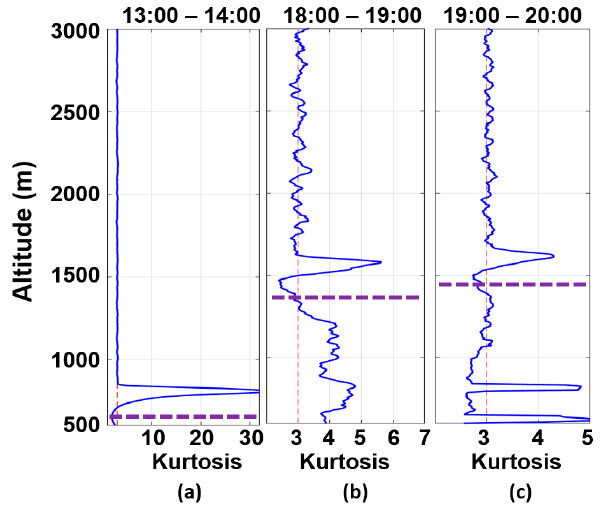
Figure 12. RCS (cid:2873)(cid:2871)(cid:2870) kurtosis profiles obtained on 23 July 2019, between ( a ) 13:00–14:00 UTC, ( b ) Figure 12. RCS 532 kurtosis profiles obtained on 23 July 2019, between ( a ) 13:00–14:00 UTC, 18:00–19:00 UTC, ( c ) 19:00–20:00 UTC. The purple dotted line represents the CBLH. ( b ) 18:00–19:00 UTC, ( c ) 19:00–20:00 UTC. The purple dotted line represents the